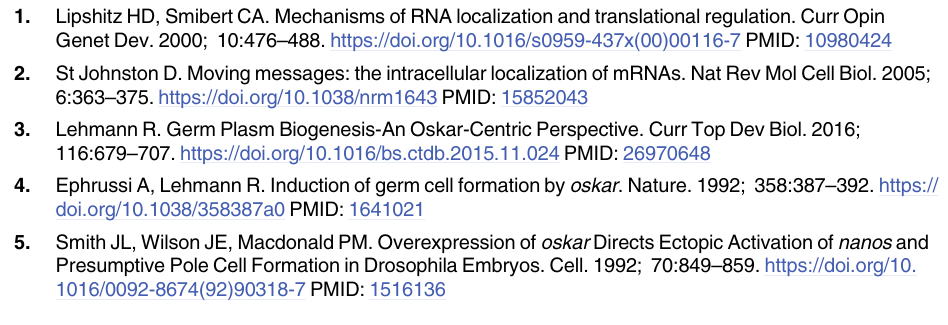
S1 File. Numerical data for figures. An Excel file with underlying data for figures, arranged by figure and